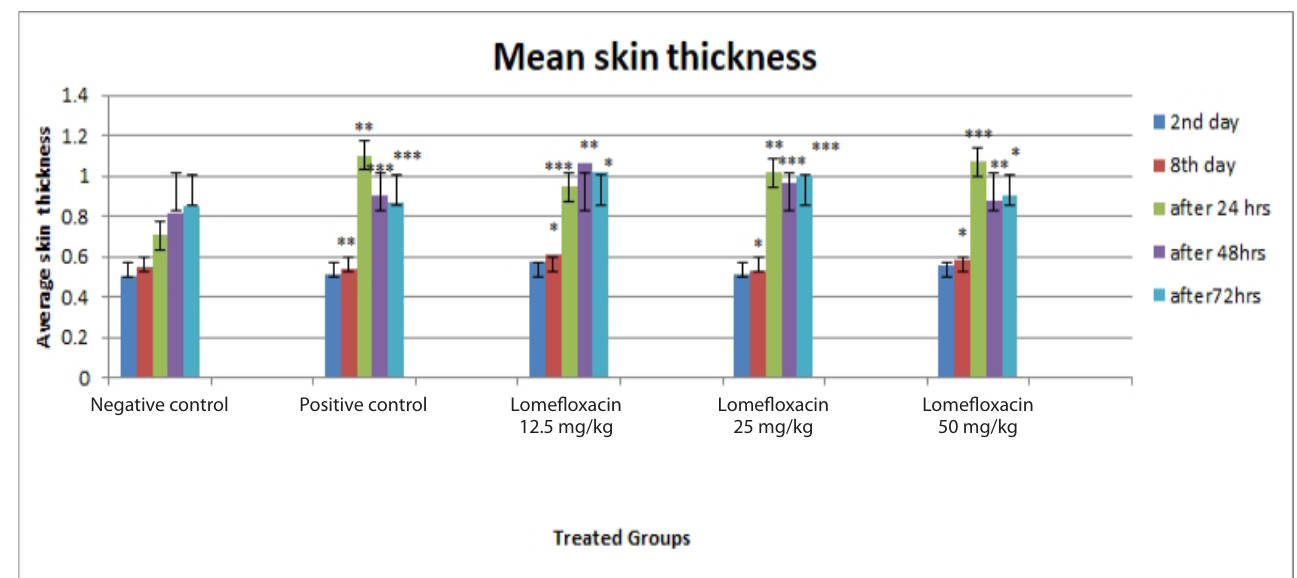
FIGURE 1 - Mean skin thickness variation among treatment groups after 24, 48 and 72 hours.